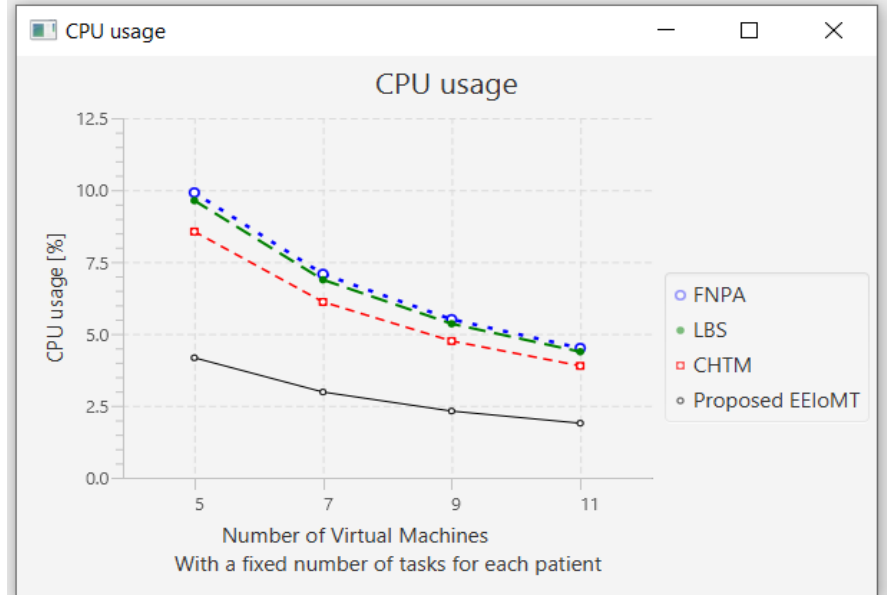
Figure 19. CPU usage comparison when changing the number of VMs.